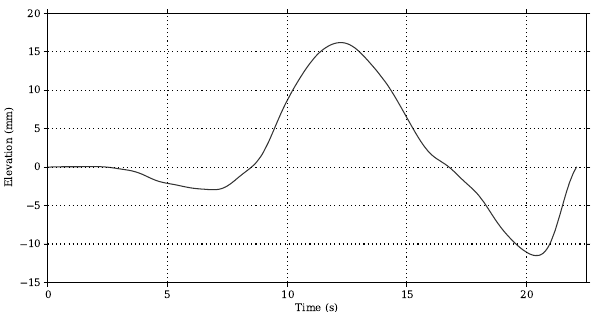
Fig. 17. Benchmark n. 4: forcing function as measured in the probe placed in position A of the tank (Fig. 16). The initial sea surface elevation of the tsunami, i.e. taken to be equal to the vertical displacement of the sea floor com- puted through Okada’s formulas (Okada, 1992), is shown for the entire grid in the panel on the upper left corner of Fig. 21 that also gives the portrait of the tsunami wave fields taken after 2, 4 and 6 min in the other panels of the same up- per row. The lower row displays the same fields but zoomed on a (10 km × 10 km) box around the area of Catania. The tsunami reaches the coast very soon. Within only 2 min